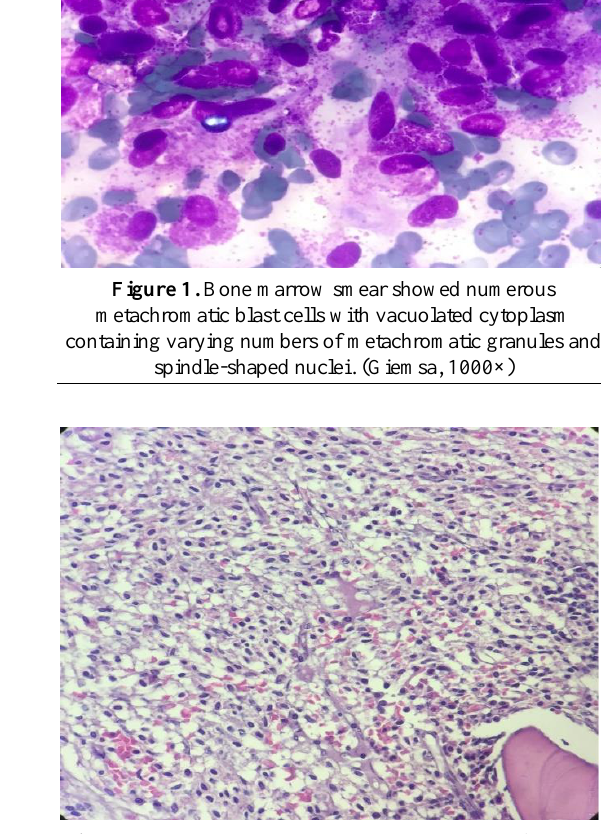
Figure 2. Bone marrow biopsy showed the sheet of spindle- shaped mast cells. (Hematoxylin and eosin,